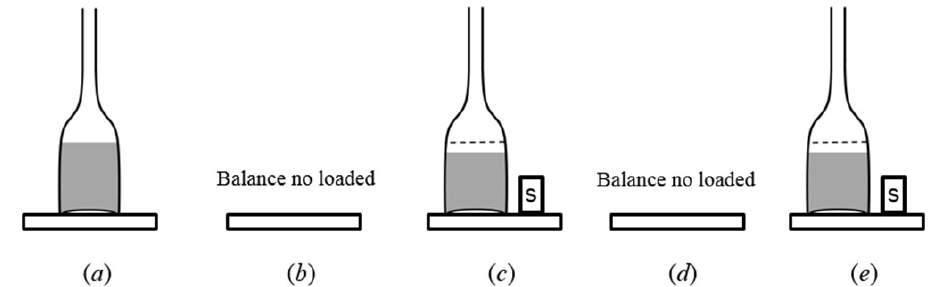
Figure 1. MEM weighing sequence: ( a ) weighing of pycnometer before drop deposition; ( b ) balance is unloaded and indication is zeroed; ( c ) 1st weighing of pycnometer together with the standard weight before drop deposition; ( d ) balance is unloaded and indication is zeroed; ( e ) 2nd weighing of pycnometer together with the standard weight before drop deposition. Usually, weighing procedures are applied to avoid drift errors as zeroing the bal- ance indication with no load before each weighing or not zeroing the balance indication for all weighing, and one records the numerical value for each indication obtained with load and no load on the weighing plate. Thus, only a residual zero-drift effect δ R D is ex- pected, and some uncertainty should be regarded for its correction.